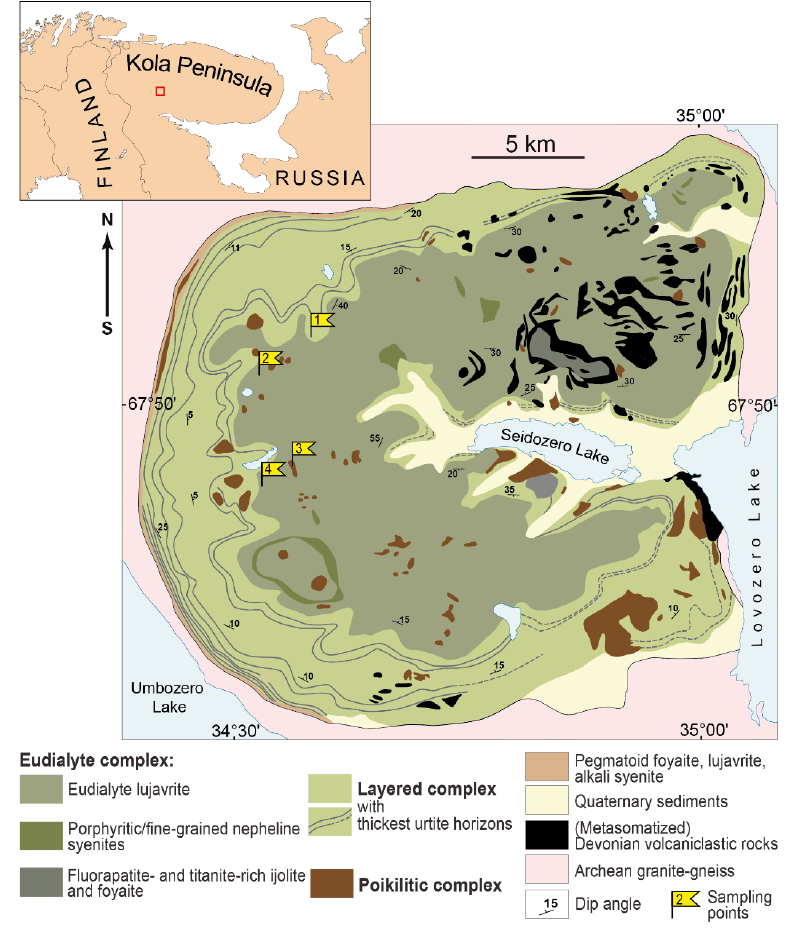
Figure 1. Geological scheme of the Lovozero alkaline massif after [16]. The Layered complex (77% of the massif’s volume; about 1.7 km in thickness) consists of numerous sub-horizontal layers or “ rhythms ” . Each rhythm is a sequence of rocks (from top to bottom): lujavrite – foyaite – urtite or lujavrite – foyaite. Lujavrite is trachytoid meso- to melanocratic nepheline syenite; foyaite is massive leucocratic nepheline syenite, and urtite is almost a monomineral nepheline rock (Table 1). The transitions between dif- ferent rocks within the same rhythm are gradual, and the boundaries between the rhythms are sharp and are often marked by pegmatites. Table 1. Summary of the petrography of the plutonic rocks of the Lovozero massif. Complex